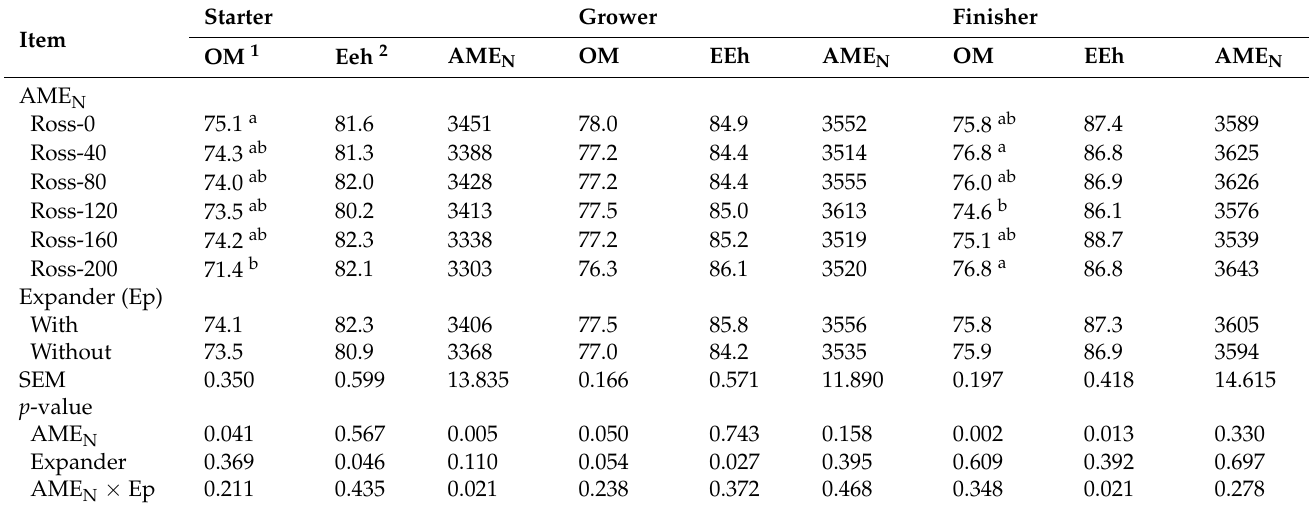
Table 6. Broiler apparent total tract digestibility (%) and AME N concentration, kcal/kg.